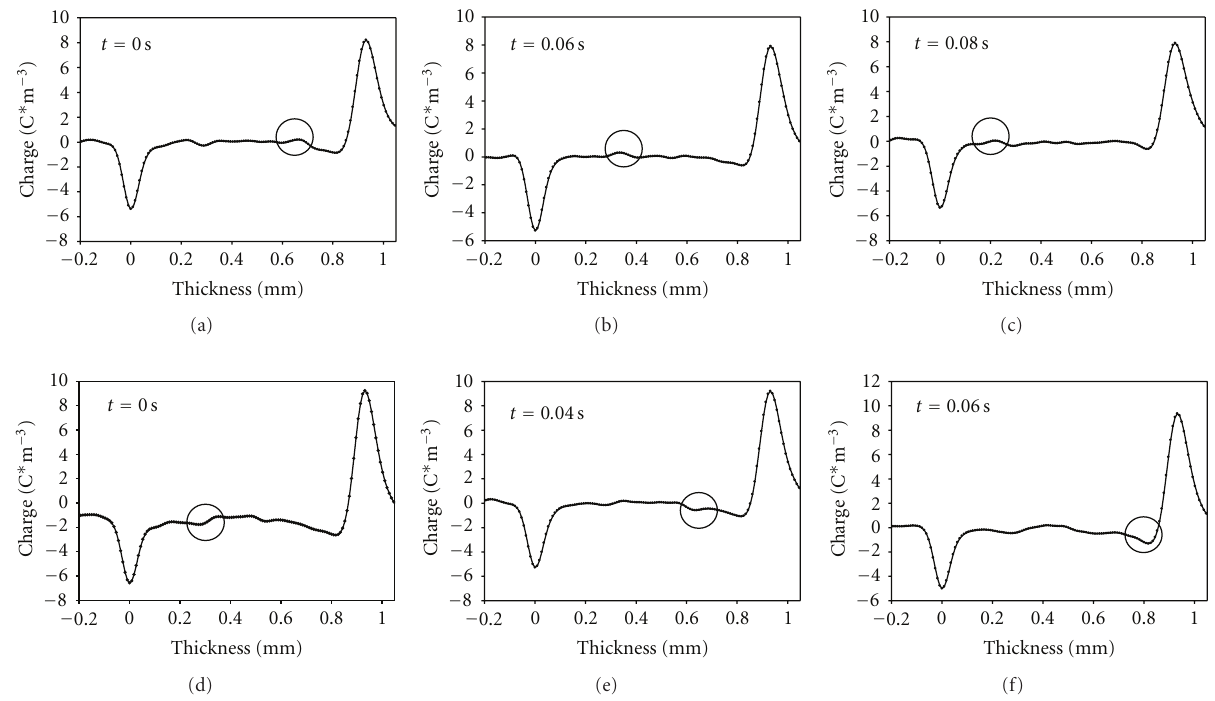
Figure 3: Evolution of charge profiles in specimen no. 0 under an electrical field of 10 kV/mm and temperature of 70 ◦ C for a positive charge pulse (a)–(c) and negative charge pulse (d)–(f).